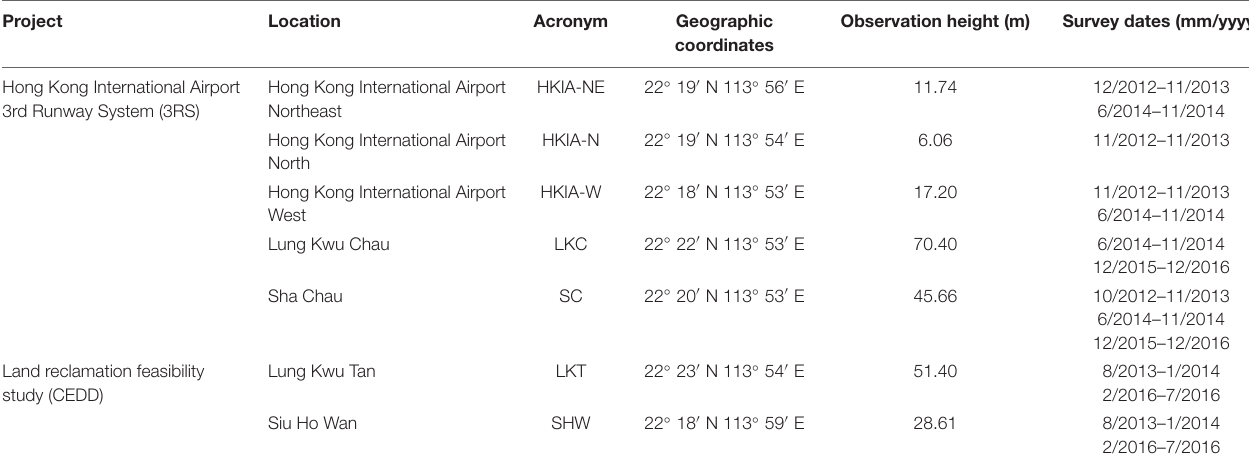
TABLE 1 | Land-based theodolite tracking sites for Indo-Pacific humpback dolphin research.